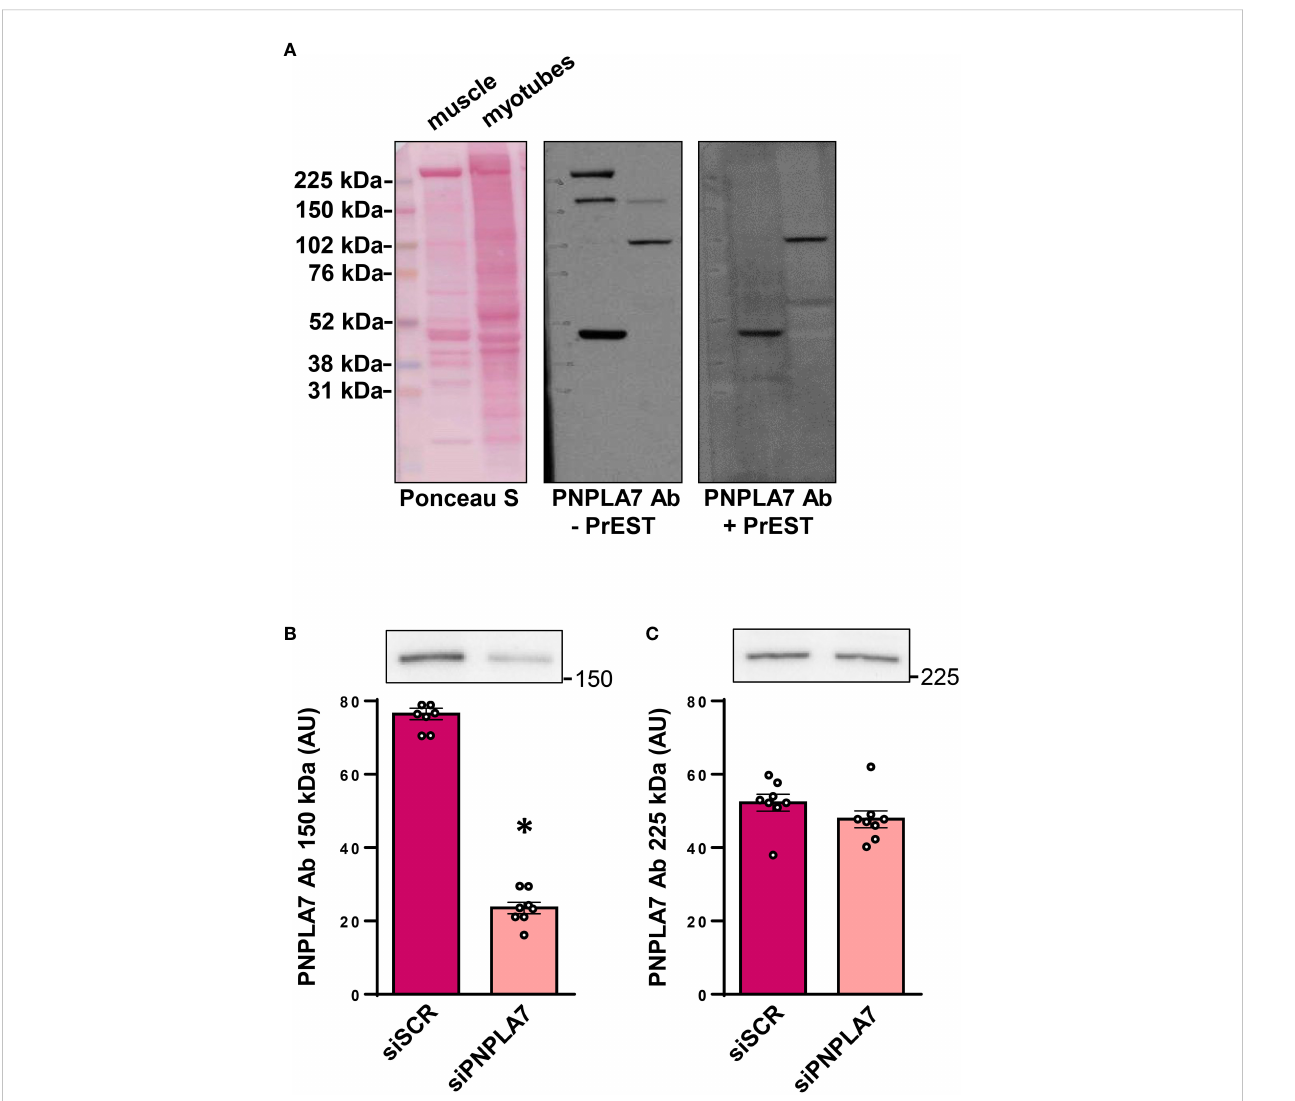
FIGURE 1 Expression of PNPLA7 in cultured human skeletal muscle cells: (A) Immunoblot of human semitendinosus muscle sample and human myotube sample (differentiated for 10 days), stained by Ponceau S, immunostained with PNPLA7 antibody (- PrEST) or immunostained with neutralized PNPLA7 antibody, prepared by preincubation with its own antigen peptid (+ PrEST). (B, C) Gene silencing: myoblasts were treated with siRNA against PNPLA7 mRNA (siPNPLA7) or scrambled siRNA (siSCR). Densitometry of immunoreactive bands (B) at ~150 kDa and (C) ~225 kDa was performed